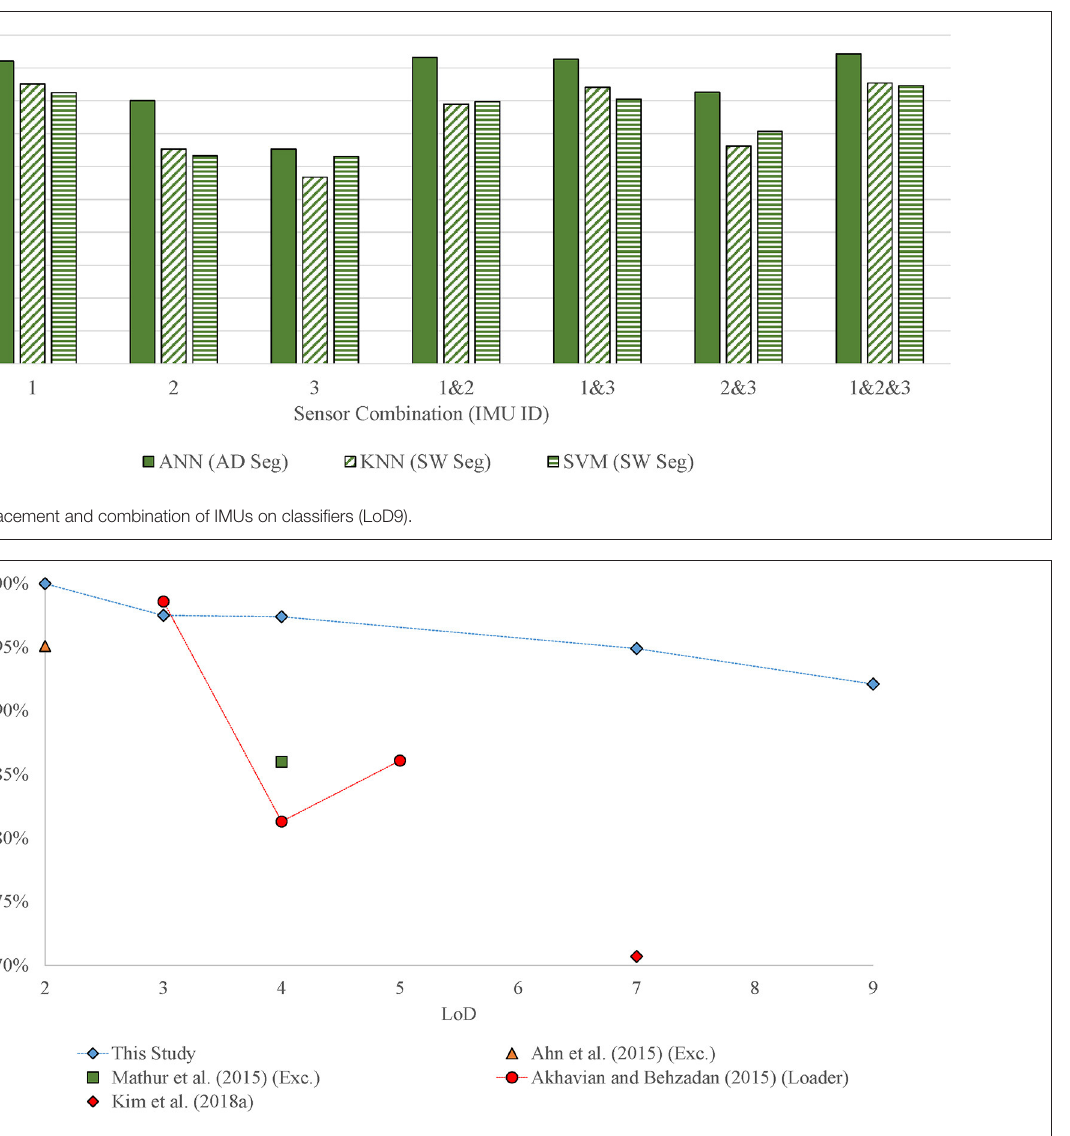
FIGURE 11 | Comparison of the results of this study with most recent studies in equipment activity